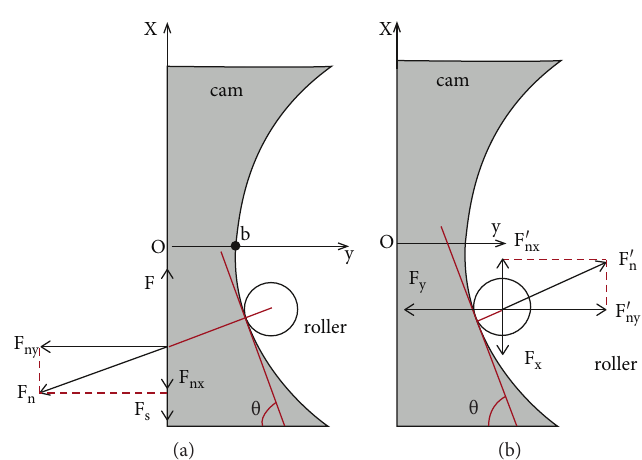
Figure 2: (a) The analysis schematics of the static force of the cam. (b) The schematics of the static force of the roller.